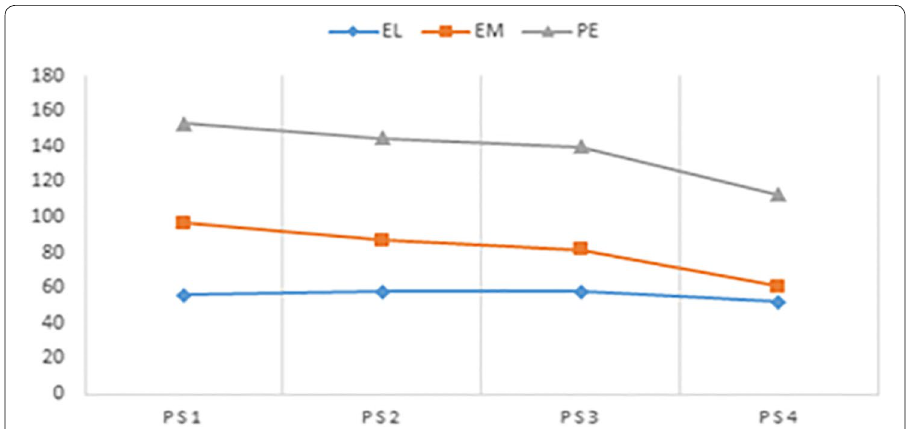
Fig. 3 Fragmentation evaluator: display the results of both parts of FE as each schema exposed on query set